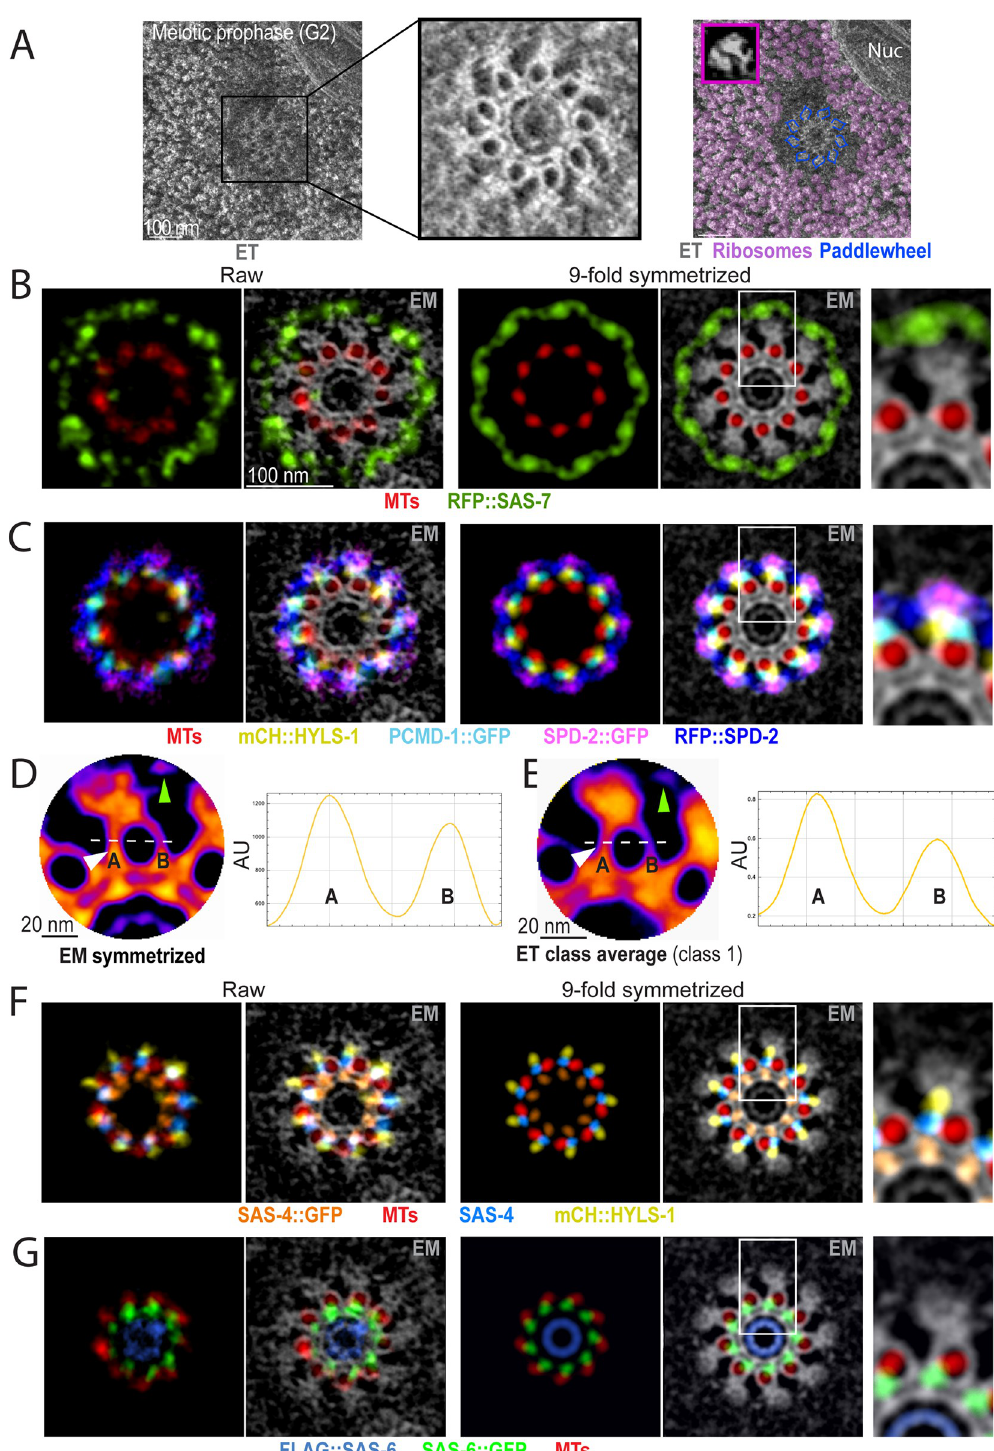
Fig 6. Overlay of EM and U-Ex images. (A) (Left) Max intensity Z-projection of ET of an early meiotic prophase centriole and surrounding region. (Middle) Magnification of the black box in the image on the left. (Right) Manually annotated ribosomes are shown in magenta and paddlewheel structures with dark-yellow outlines. Note that the ribosome-free area extends beyond the paddlewheels. Purple inset shows a magnified ribosome from the same ET image. (B, C, F, G) Overlay of U-Ex-STED and EM images (inverted grey levels) of centrioles from early meiotic prophase. Circularized images (left